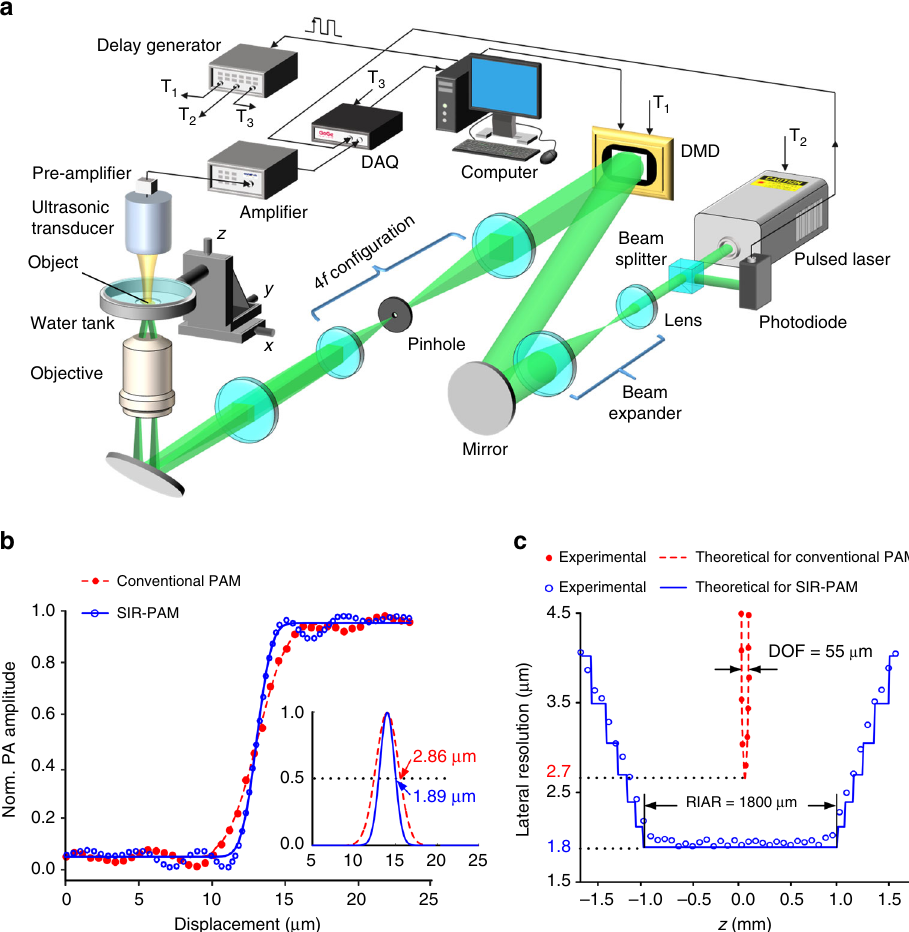
Fig. 2 Experimental set-up and characterization of SIR-PAM system. a Schematic illustration of the SIR-PAM system. DAQ data acquisition system; DMD digital micromirror device; T 1 DMD trigger; T 2 pulsed laser trigger; T 3 DAQ trigger. b Normalized (Norm.) edge spread functions of conventional PAM and SIR-PAM, measured at the focal plane using a sharp edge made of deposited chromium. The corresponding line spread functions were fi tted to compute the lateral resolutions de fi ned by the full-width at half-maximum ( inset ). c Theoretical and experimental lateral resolutions of the two PAM systems versus depth. DOF depth of fi eld; RIAR resolution-invariant axial